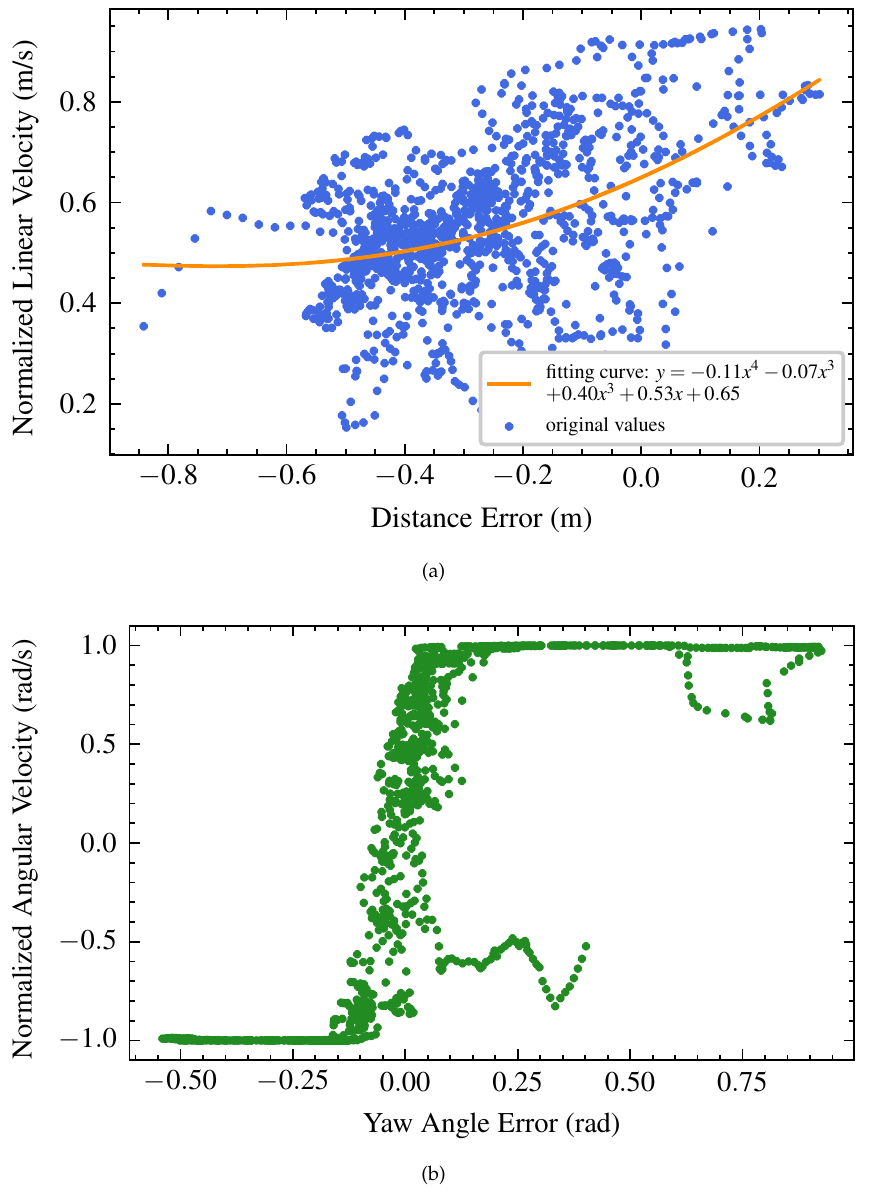
Figure 9. Visualization of the mapping from the state errors to the corresponding actions. ( a ) Mapping from the ground truth depth error to the output normalized linear velocity. ( b ) Mapping from the ground truth yaw angle error to the output normalized angular